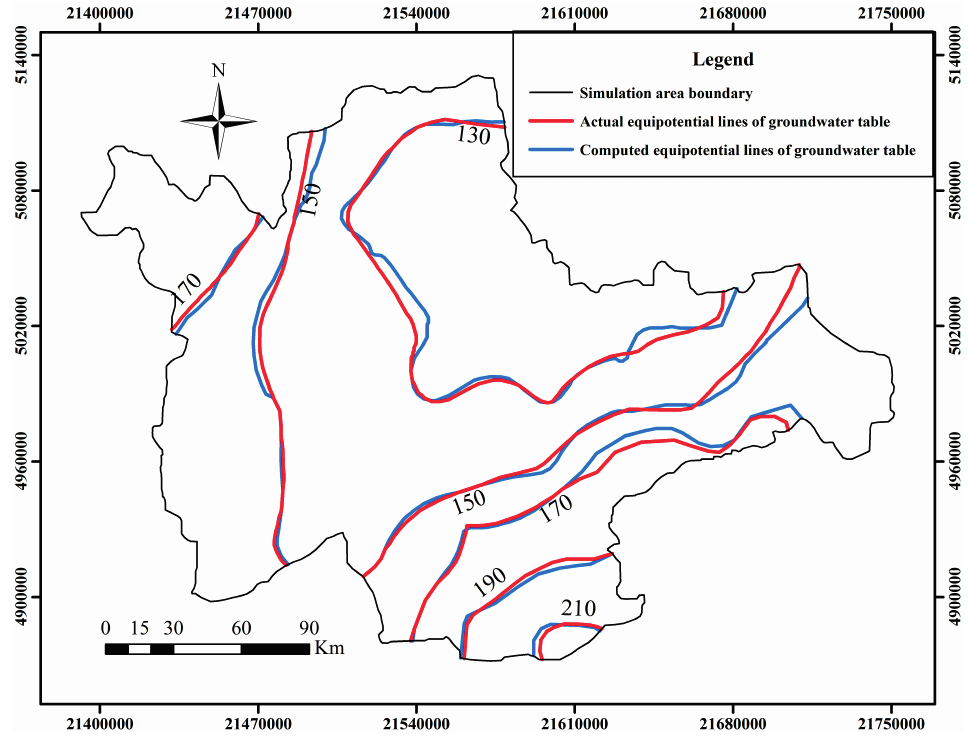
Figure 7. The actual and computed equipotential lines of groundwater table at the end of the model verification stage.